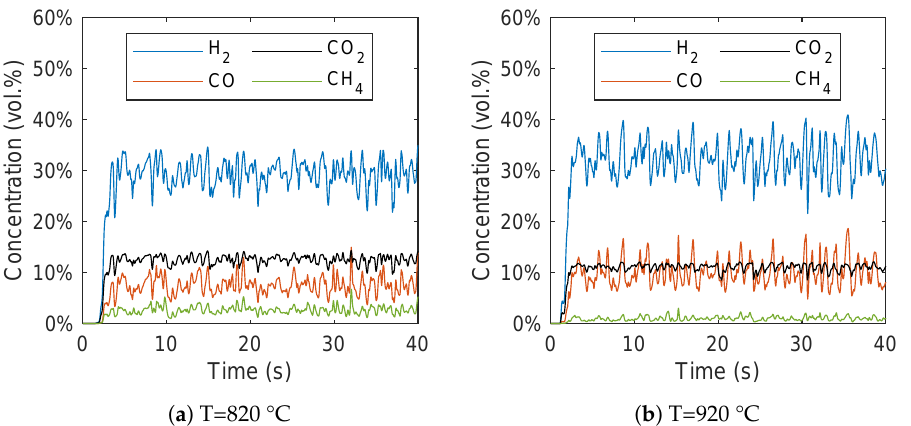
Figure 8. Gas species concentration plotted over time at reactor temperatures of ( a ) 820 °C and ( b ) 920 °C.